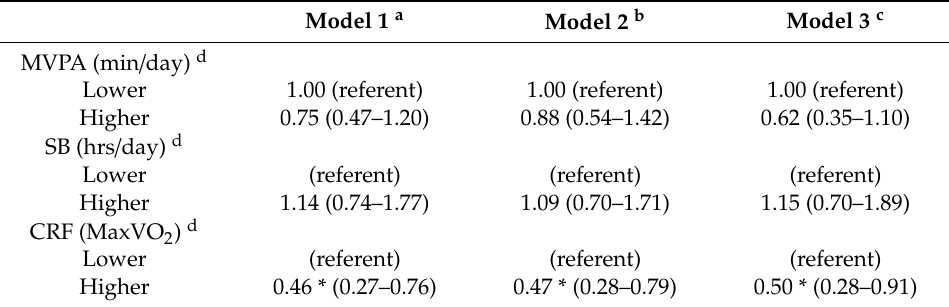
Table 2. Independent Associations of SB, MVPA and CRF with Sleep